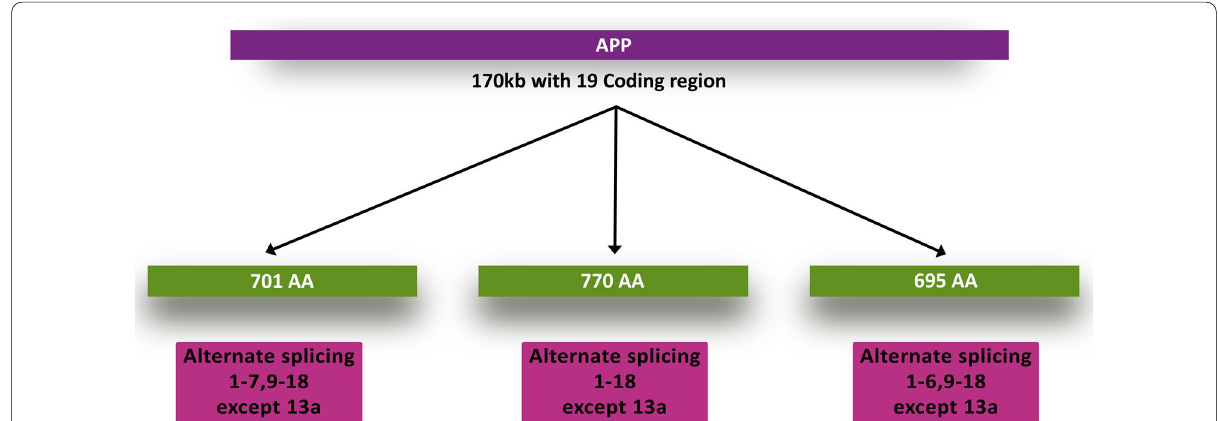
Fig. 1 Alternative splicing of APP mRNA to produce 3 different isoforms of APP protein. The above diagram shows how alternative splicing of same amyloid precursor protein (APP) can produce different isoform of APP protein. The APP gene contains 19 exons, 170 kb end to end. The alternative splicing of exons 1 to 13, 13a, and 14 to 18 results in the isoforms. The isoform 695 is produced by the alternative splicing of exons 1–6, 9–18, excluding 13a, and APP 751 by exons 1–7, 9–18, excluding 13a. APP 770 is exons 1–18, excluding